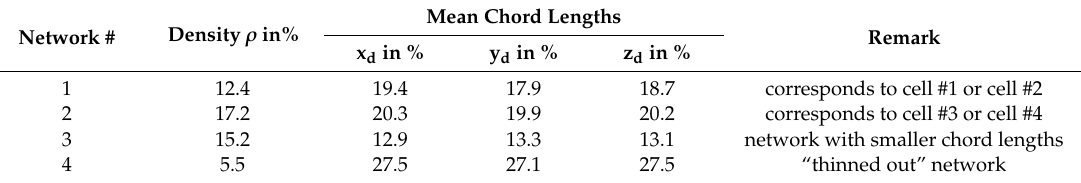
Table 3. Computed actin network densities and relative chord lengths for four artificially created actin